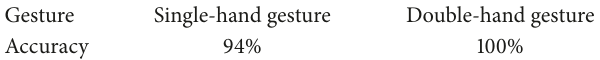
Table 11: The cross-validation accuracy on training